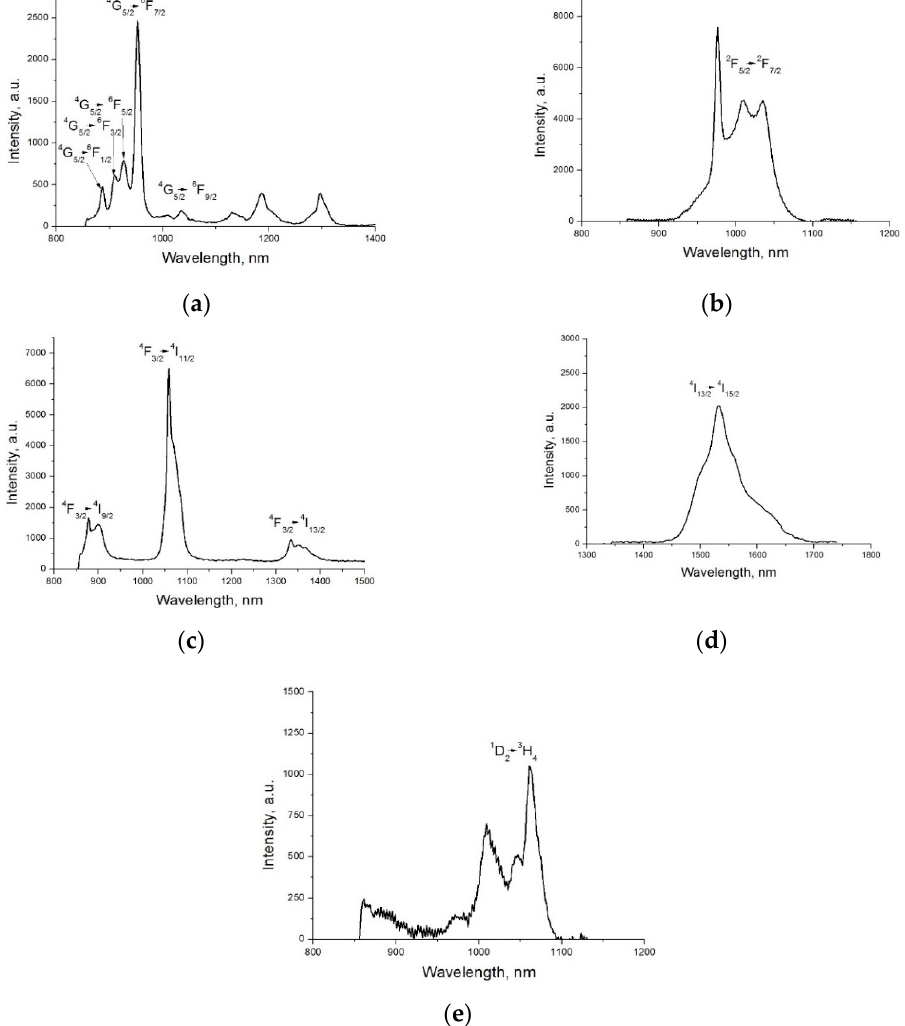
Figure 5. Luminescence spectra of the films containing ( a ) Sm(III), ( b ) Yb(III), ( c ) Nd(III), ( d ) Er(III) and ( e ) Pr(III) complexes in the near IR range.